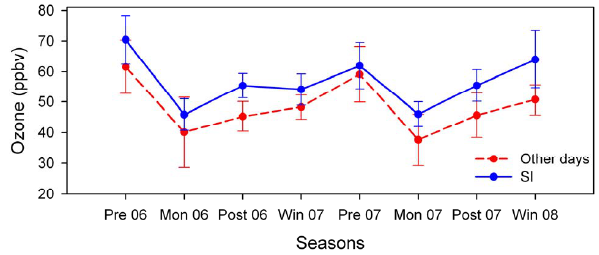
Figure 6. Average O 3 concentrations recorded during SI and during periods not affected by SI 2 Fig. 6. Average O 3 concentrations recorded during SI and during (Other days) at NCO-P for the period March 2006 – February 2008. Vertical bars represent the 3 periods not affected by SI (Other days) at NCO-P for the period standard deviations. 4 March 2006–February 2008. Vertical bars represent the standard